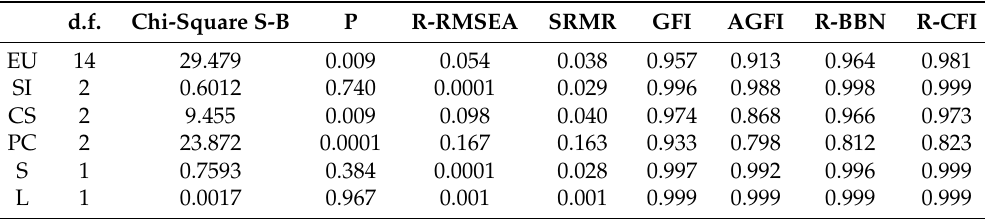
Table 3. Measurement Models. Goodness-of-Fit.